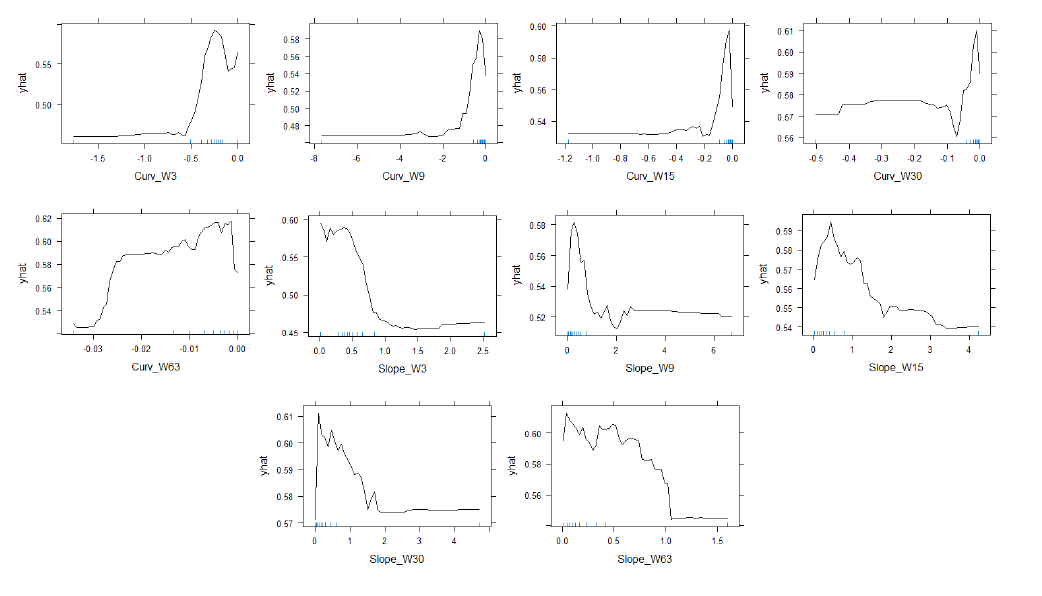
Figure 13. Partial dependence plots obtained for negative Curvature and Slope with NDVI for resampled